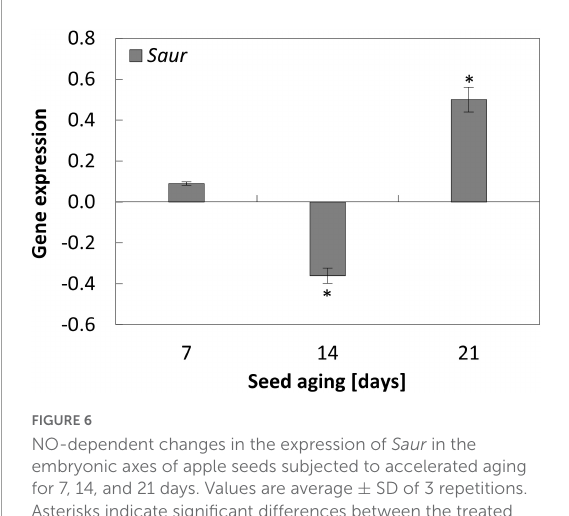
FIGURE6 NO-dependent changes in the expression of Saur in the embryonic axes of apple seeds subjected to accelerated aging for 7, 14, and 21 days. Values are average ± SD of 3 repetitions. Asterisks indicate significant differences between the treated sample compared to the control sample, obtained by the Student’s t -test ( P <